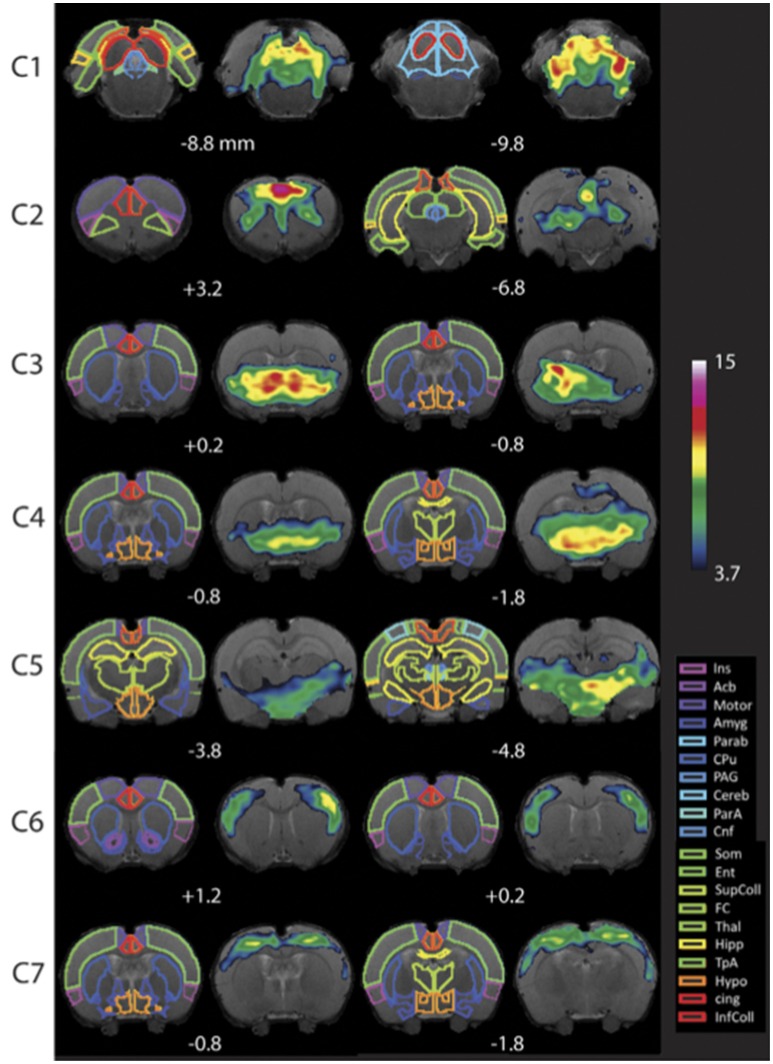
Resting-state networks in awake rats. Complete maps for Components (C1–C7). All components have been thresholded according to a mixture model approach. See Methods from Becerra et al. (2011b) for details. The atlas is based on the Paxinos and Watson Atlas (1998). Abbreviations: Ins, Insula; AcB, Nucleus Accumbens; Motor, Motor Cortex; Amyg, Amygdala; Parab, Parabrachial; CPu, Caudate-Putamen; PAG, Periaqueductal Gray; Cereb, Cerebellum; ParA, Parietal Association Cortex; Cnf, Cuneiform Nucleus; Som, Somatosensory Cortex; Ent, Entorhinal Cortex; SupColl, Superior Colliculus; FC, Frontal Cortex; Thal, Thalamus; TpA, Temporal Association Cortex; Hypo, Hypothalamus; cing, Cingulate Cortex (anterior and retrosplenial); InfColl, Inferior Colliculus. Figure reprinted with permission from Becerra et al. (2011b).